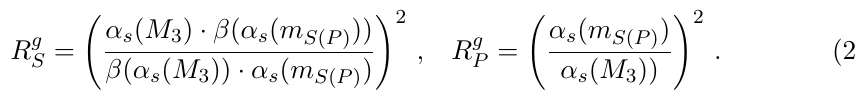
Figure 1 . Correction factor R g of sgoldstino